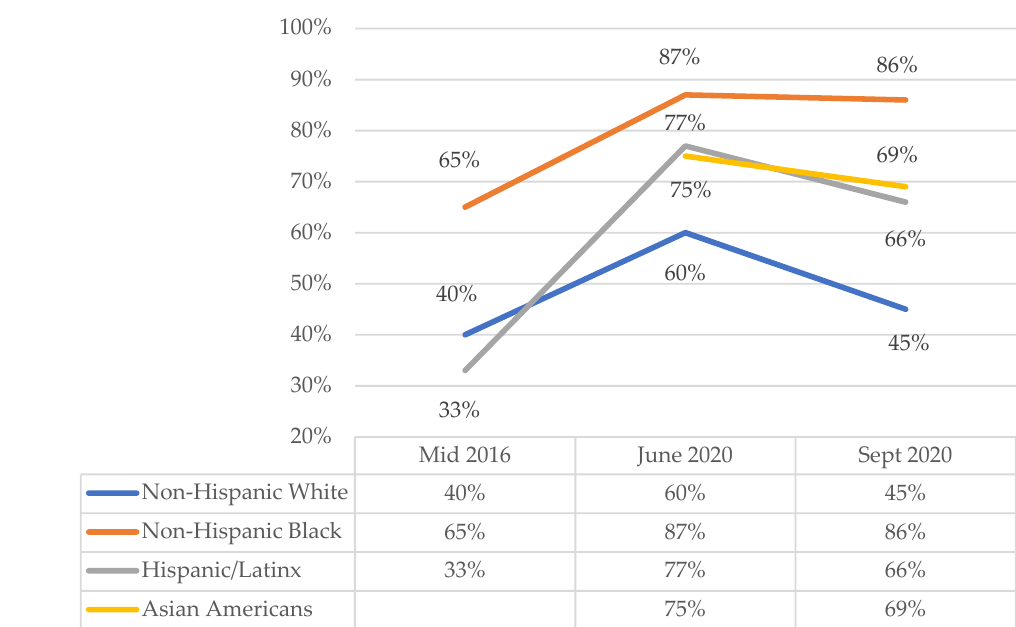
Figure 1. Changes in percentages of supporting Black Lives Mater by racialized groups for non-Hispanic/Latinx White, non-Hispanic/Latinx Black, Hispanic/Latinx, and Asian American adults 2016-2020. Source: Three nationally representative surveys conducted by Pew Research Center. Note: Estimates for 2016 come from Horowitz and Livingston (2016); June 2020 estimates come from Parker et al. (2020); and Sept 2020 estimates come from Thomas and Horowitz (2020). Asian Americans were not included in the survey in 2016.